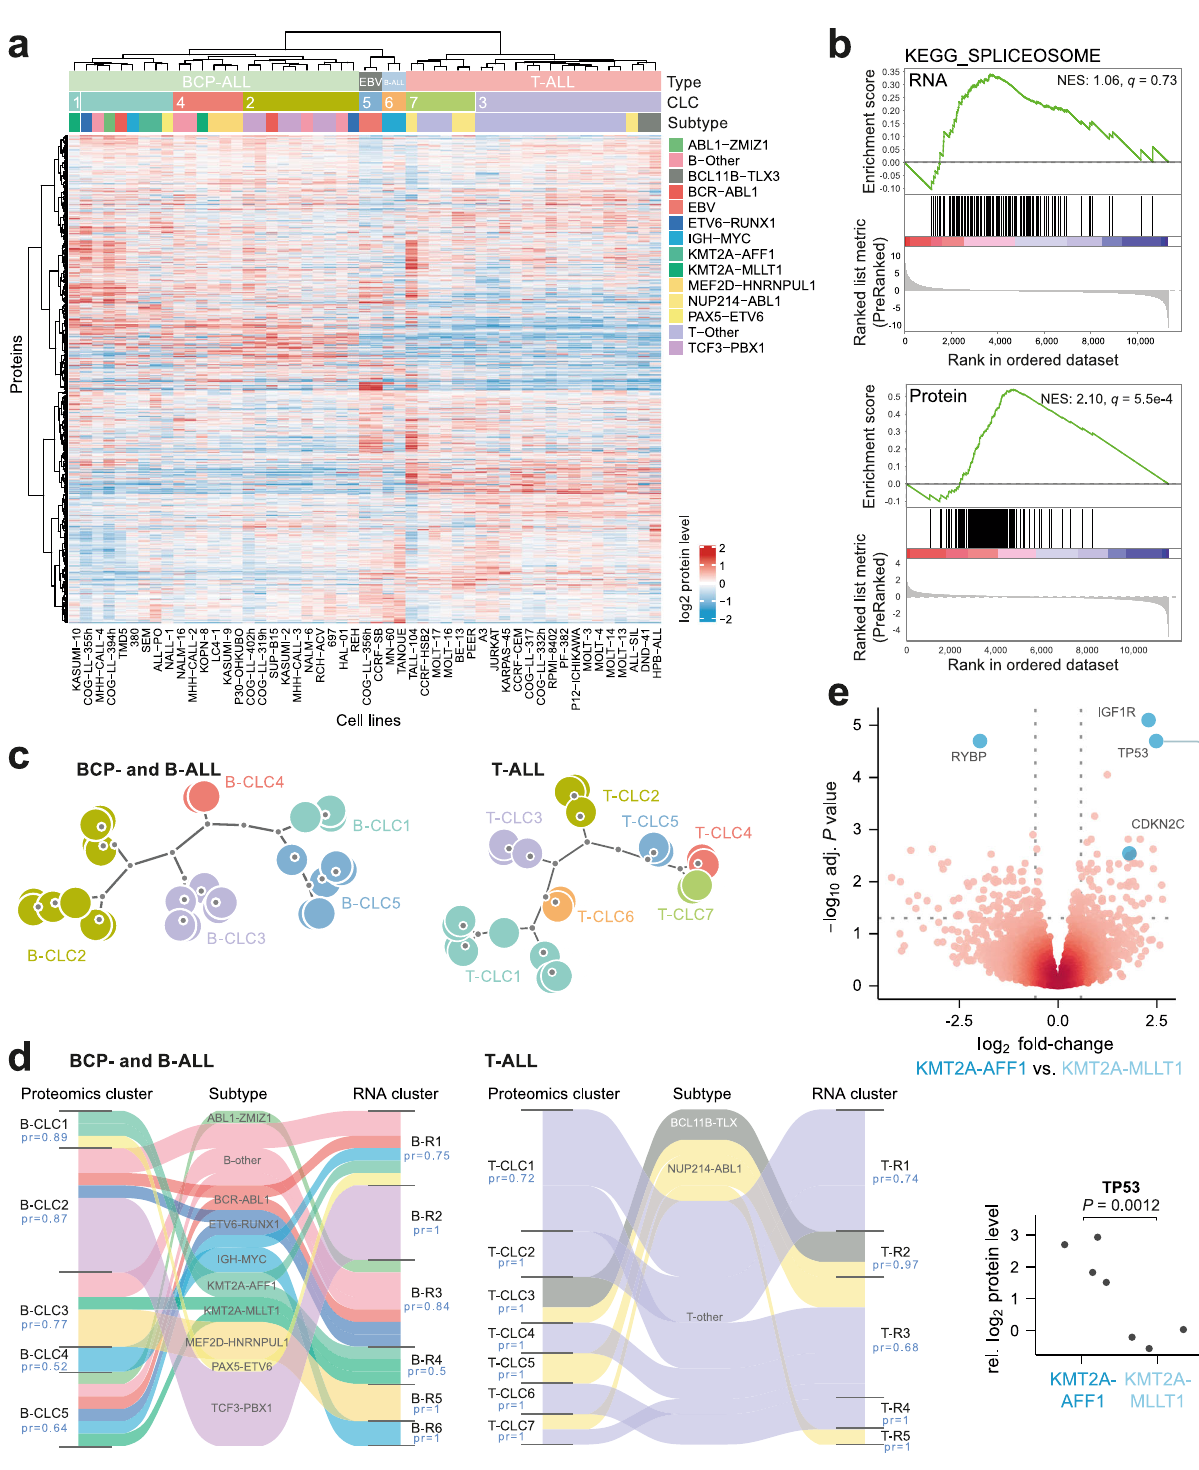
Fig. 3 MS-based quanti fi cation and clustering of the proteome of childhood ALL cell lines. a Heatmap showing the hierarchical clustering of the total overlap of 9100 identi fi ed and quanti fi ed proteins across 51 cell lines. b GSEA of the differentially expressed genes in CLC3 versus the remaining T-ALL cell lines using the proteomics and transcriptomic data showing signi fi cant enrichment of the spliceosome in the proteomics data (NES = 2.1, adjusted P value q = 5.5e-4) but not in the transcriptomic data (NES = 1.06, adjusted P value q = 0.73). Only one biological replicate from the proteomics data was used to have matching numbers and an unbiased comparison to the transcriptomics data. The signi fi cance of NES was assessed by Kolmogorov – Smirnov statistics. c Dendrogram of the consensus clustering of the B-lineage and T-lineage separately showing fi ve CLC for B-lineage (B)-CLC) and seven CLC for T-lineage (T-CLC) cell lines. d Sankey diagram, showing connection nodes between proteomics CLCs and mRNA-based CLCs, by cytogenetic subtype. The approximately unbiased bootstrapping probability (pr) are indicated for each cluster. e Volcano plot of differentially abundant proteins in the KMT2A-AFF1 cell lines compared to the KMT2A-MLLT1 cell lines (top panel) using DEqMS and the TP53 levels in KMT2A-AFF1 cell lines compared to the KMT2A-MLLT1 cell lines (bottom panel) using two-sided, unpaired t -test, P value ( p ) is shown in the plot. Source data are provided as a Source Data File